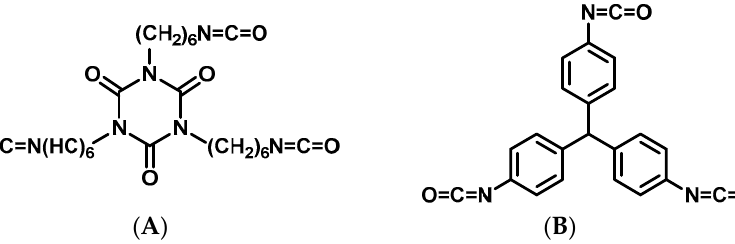
Figure 1. Structures of the triisocyanates contained in the commercial products referred to as Desmodur N3300 and Desmodur RE. In this publication the triisocyanate contained in Desmodur N3300 is referred to as N3300 ( A ) and the triisocyanate contained in Desmodur RE is referred to as TIPM ( B ).